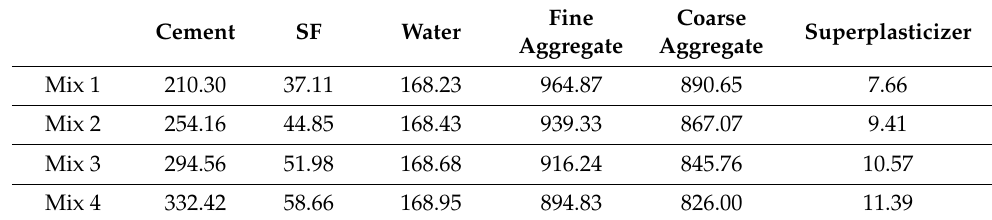
Table 6. Optimal design mixtures for Case 1: low-CO 2 concrete without carbonation (unit: kg/m 3 ).